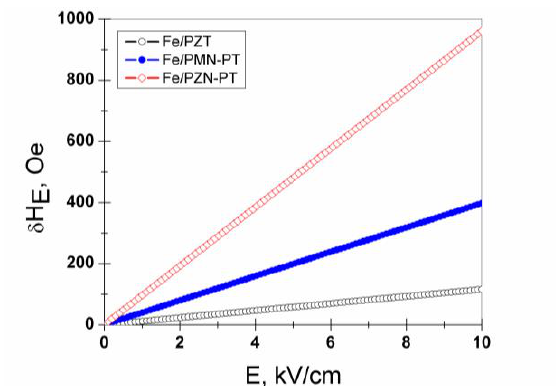
Fig. 1. Result of the FMR line shift calculation for composite structures of Ni/PZT, Ni/PMN-PT and Ni/PZN-PT. Results for Fe deposited on PZT, PMN-PN and PZN-PT are shown on Fig. 2.